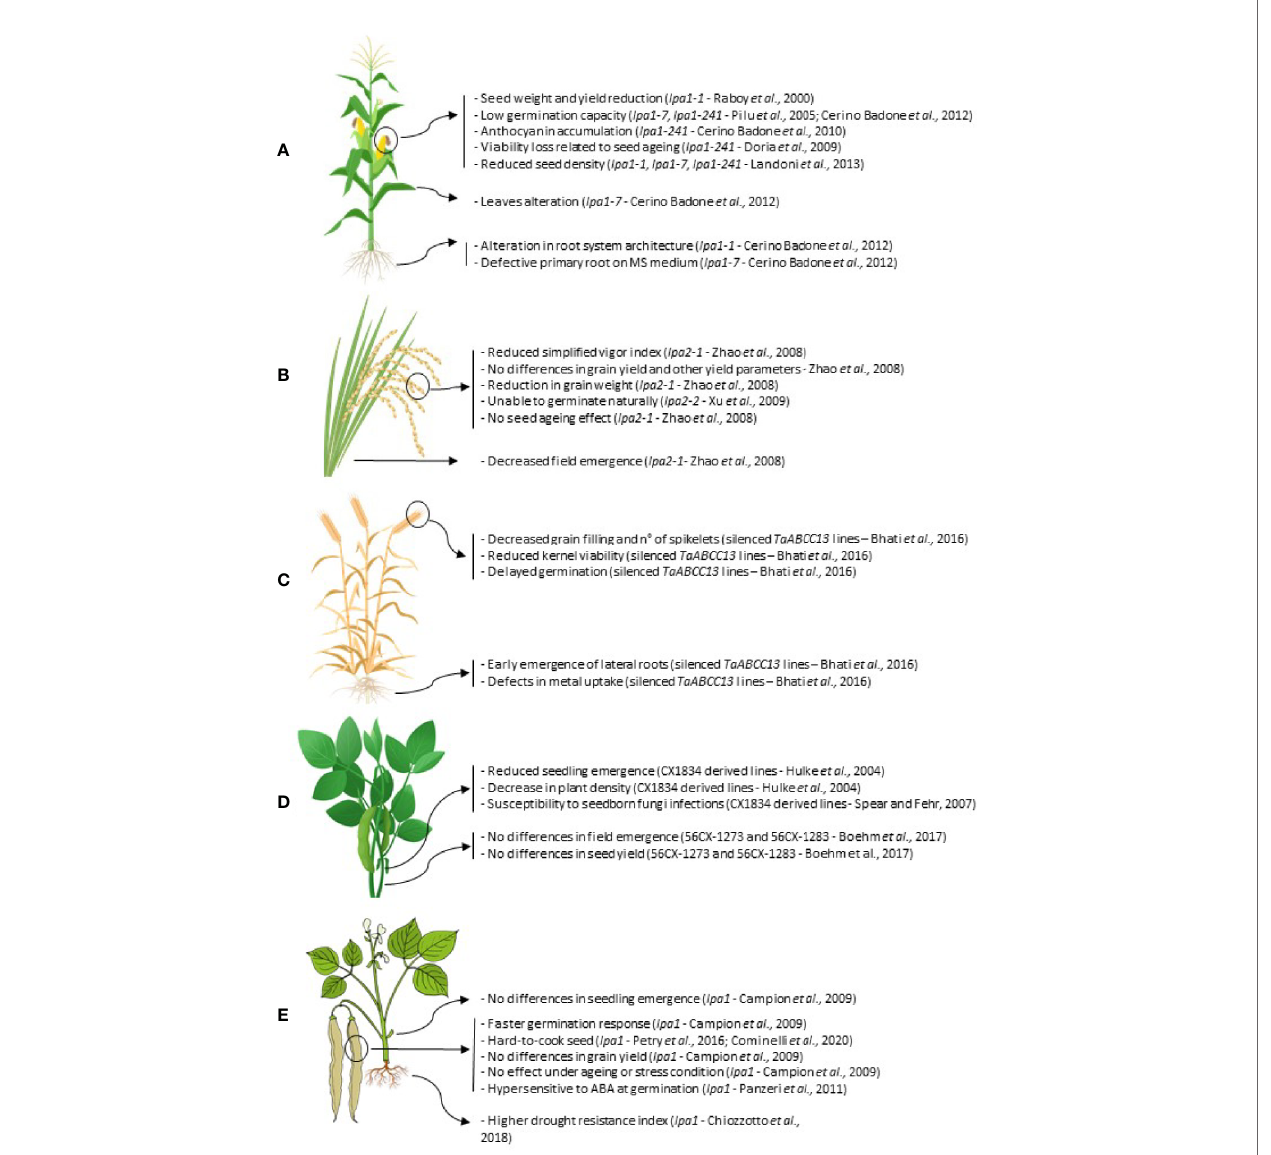
FIGURE 3 | Summary of the main pleiotropic effects in lpa mutations in the fi ve agronomic species considered: maize (A) ; rice (B) ; hexaploid wheat (C) ; soybean (D) and common bean (E)